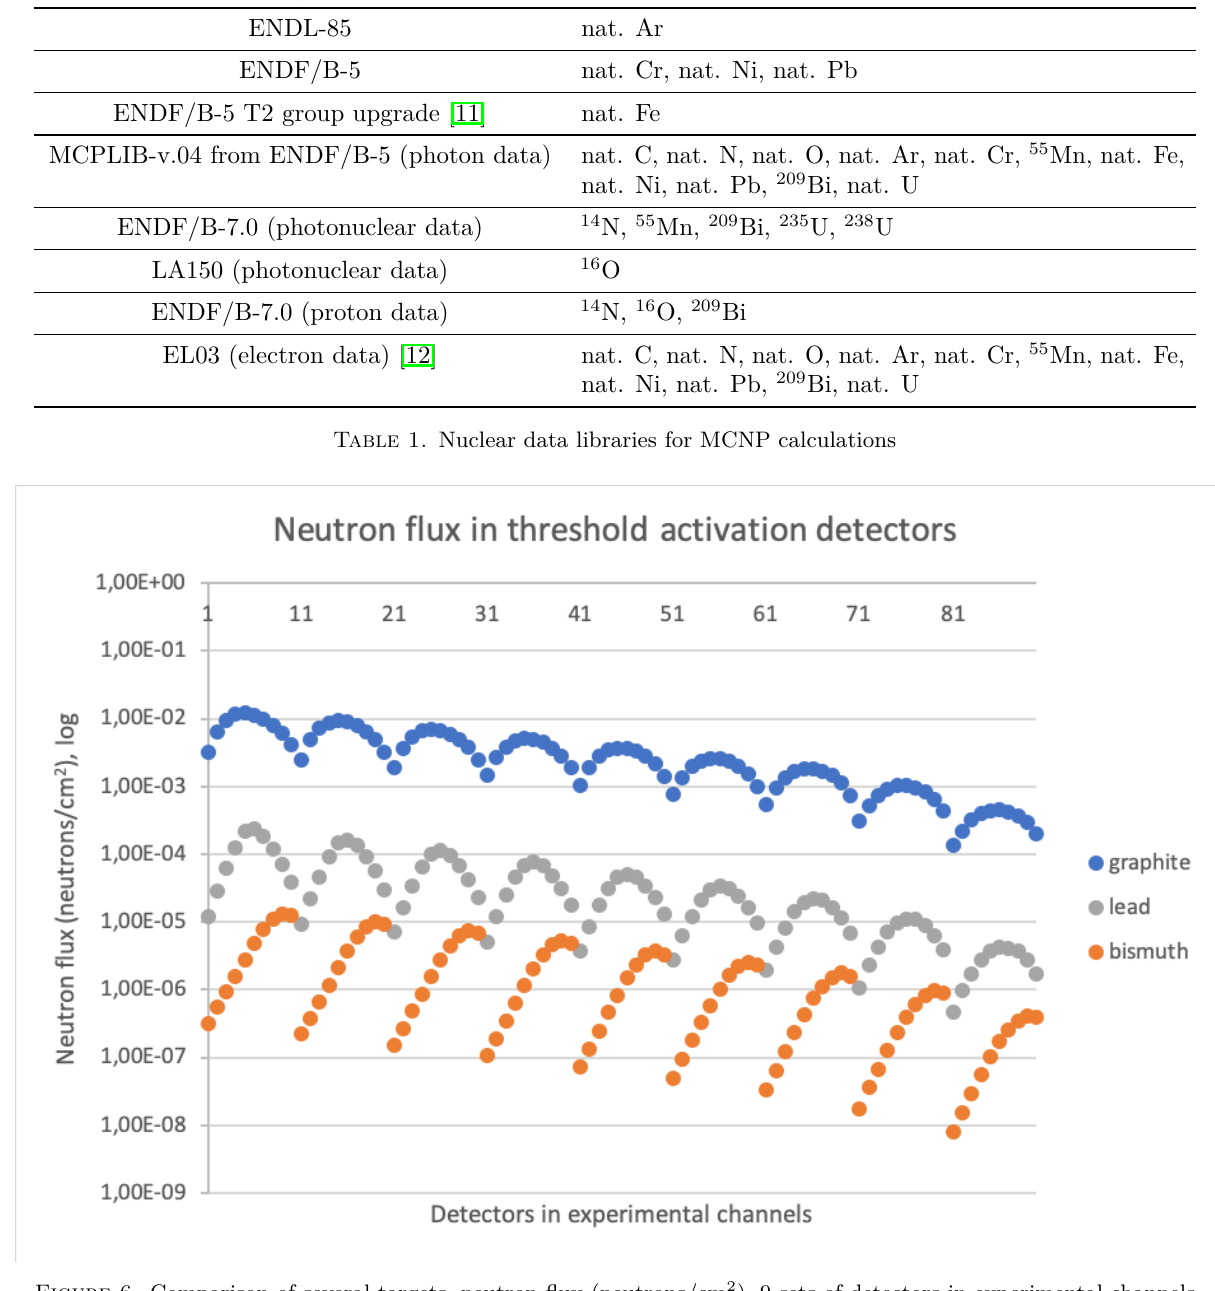
Figure 6. Comparison of several targets, neutron flux (neutrons/cm 2 ), 9 sets of detectors in experimental channels (calculated by